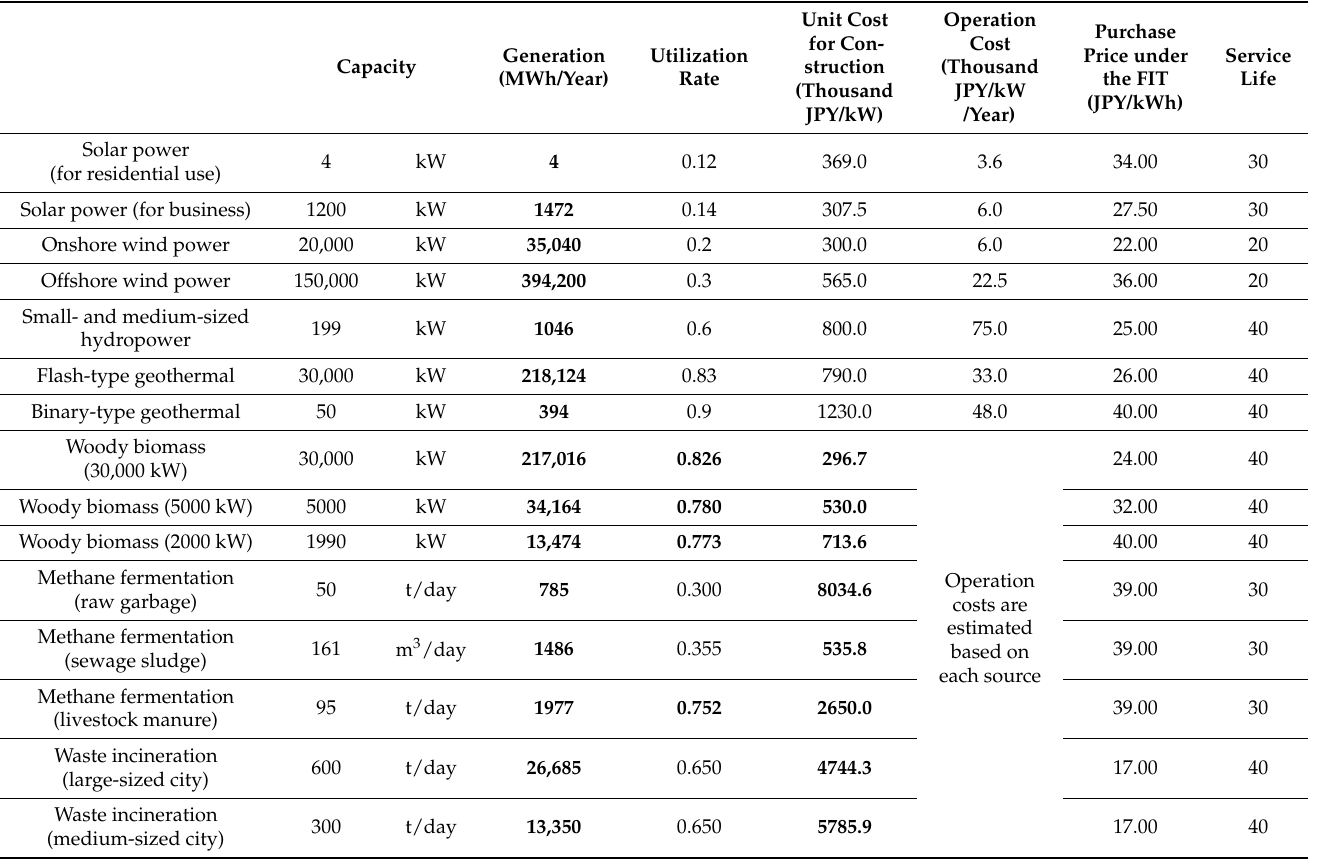
Table 2. Power plant specifications used for estimation in the 2015